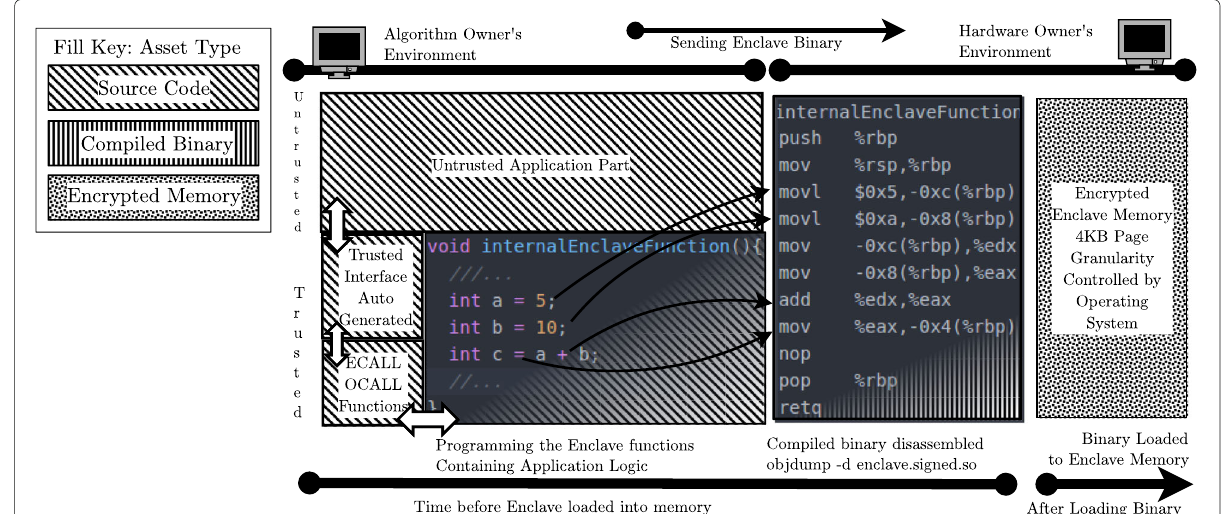
Fig. 1 Default Enclave Execution Mechanism of SGX between the Algorithm Owner ( AO ) and Hardware Owner ( HO ). The operator of the machine, the HO , can inspect the enclave code by reverse engineering the enclave binary. Enclaves must not include any secrets embedded in binary. Enclaves can, however, receive secrets through a secure channel or recover sealed data